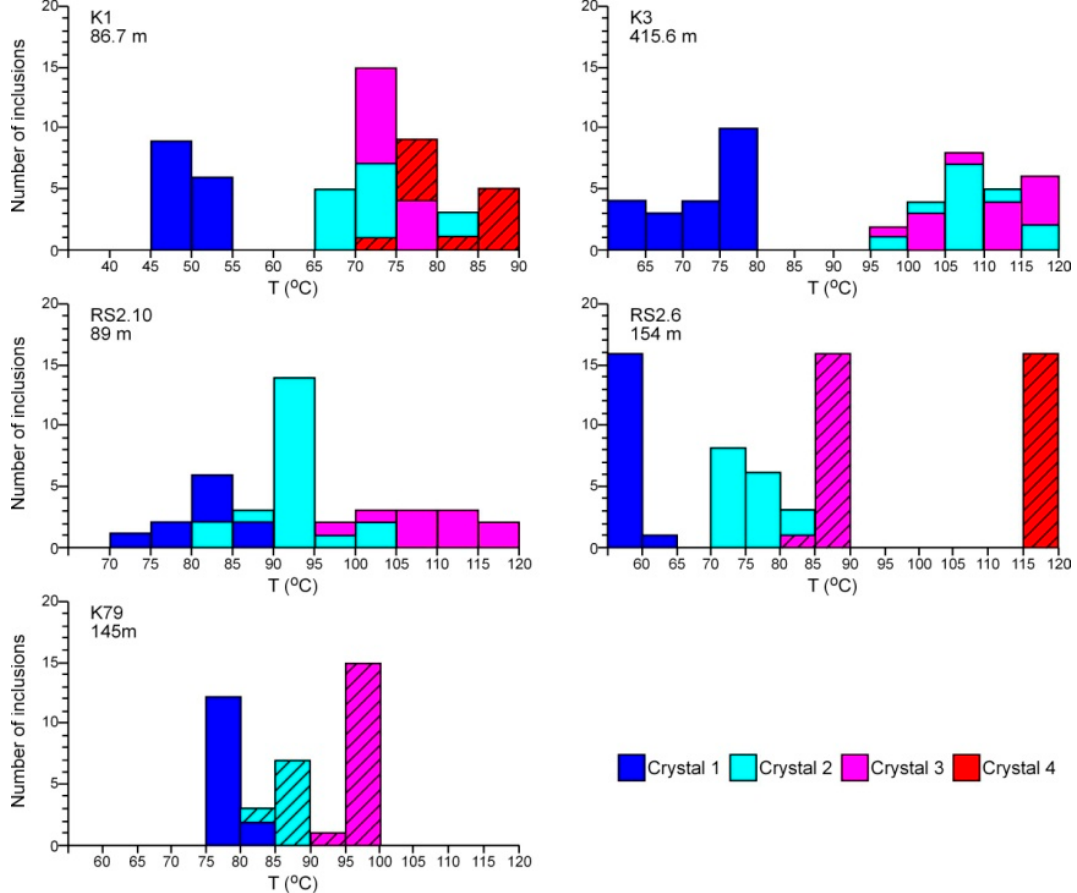
Figure 5. Dissolution temperatures of sylvite and carnallite daughter crystals in 277 primary fluid inclusions in halite from the Maha Sarakham Formation. Colors represent different halite crystals. Diagonal lines are fluid inclusions from chevron halite crystals; all others are cumulate halites.